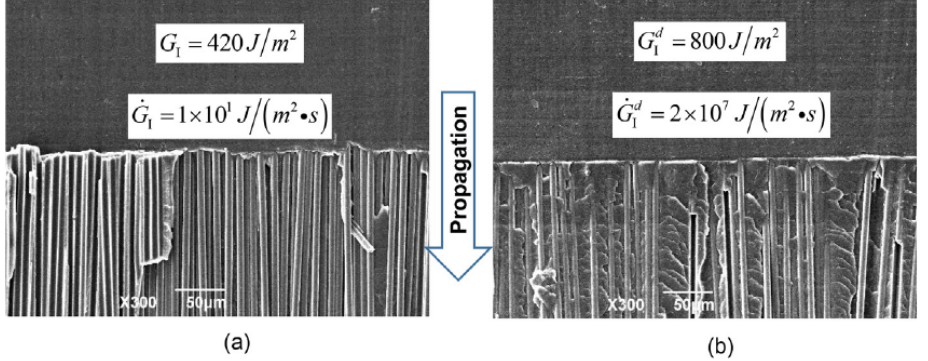
Figure 7. A typical scanning electronic microscopy image of DCB fracture surfaces at a magnification of 300 under ( a ) quasi-static and ( b ) dynamic loading [41].